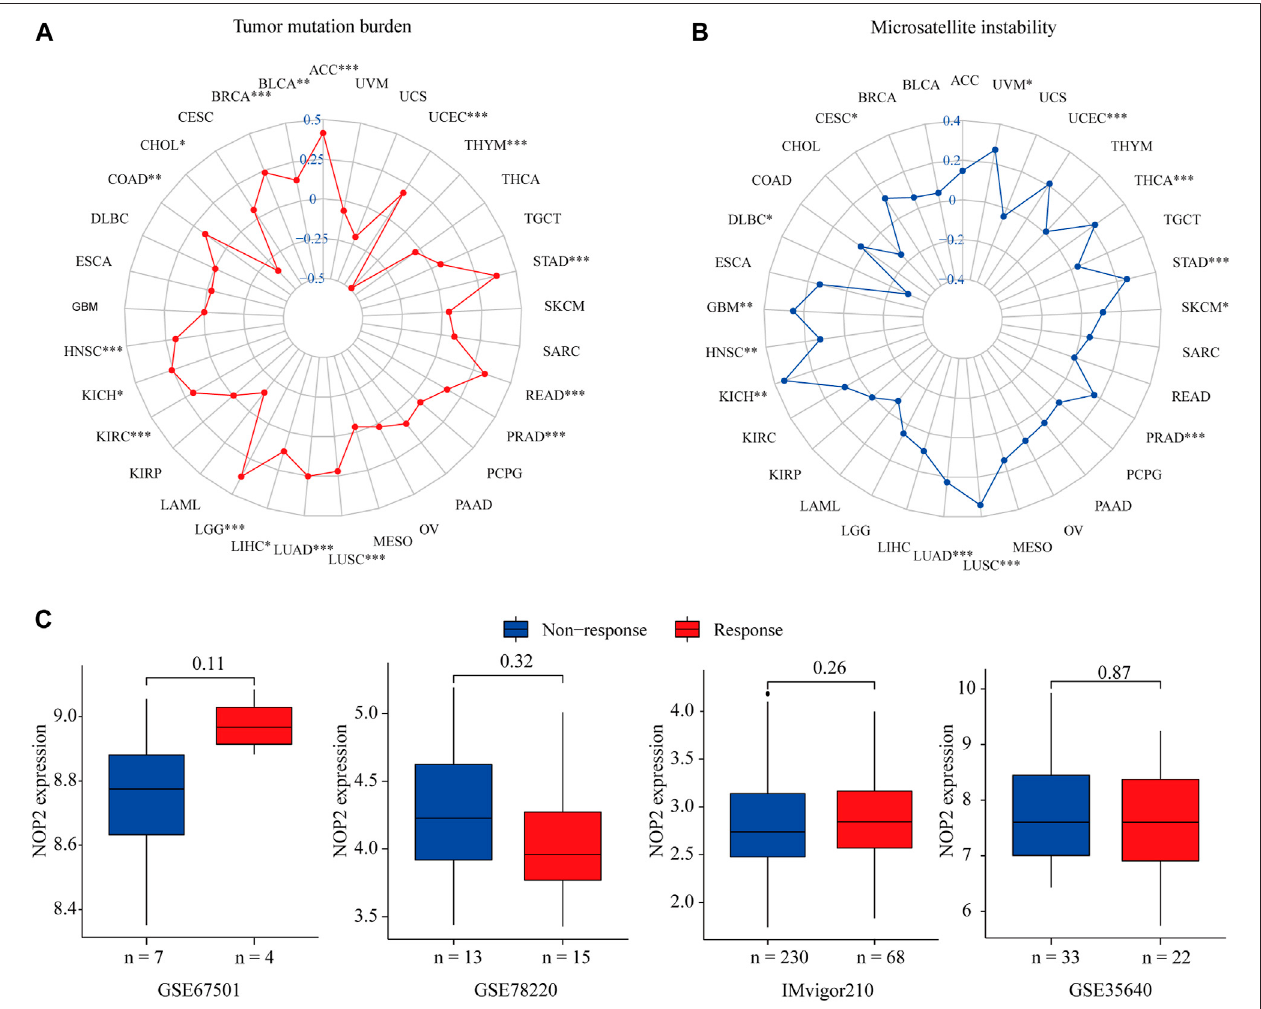
FIGURE10| CorrelationbetweenNOP2 expression and TMB, MSI, and theimmunotherapeutic responsein33types ofcancers. (A) Correlationsbetween NOP2 expression and TMB. (B) Correlation between NOP2 and MSI. (C) Correlations between NOP2 and immunotherapeutic response in GES67501, GSE78220, and